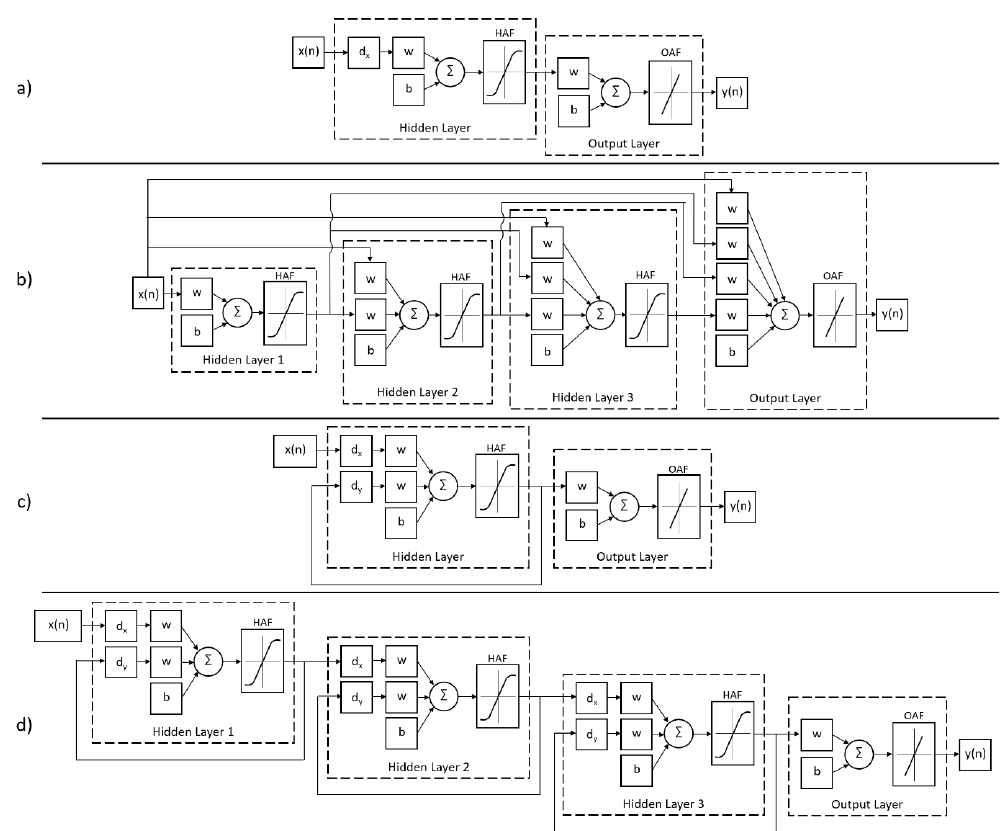
Figure 2. Artificial Neural Network architectures designed and evaluated for SOC estimation. ( a )